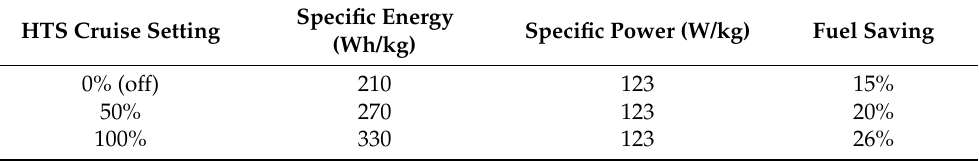
Table 9. Hybrid-electric aircraft with structural power composite airframe performance requirements.